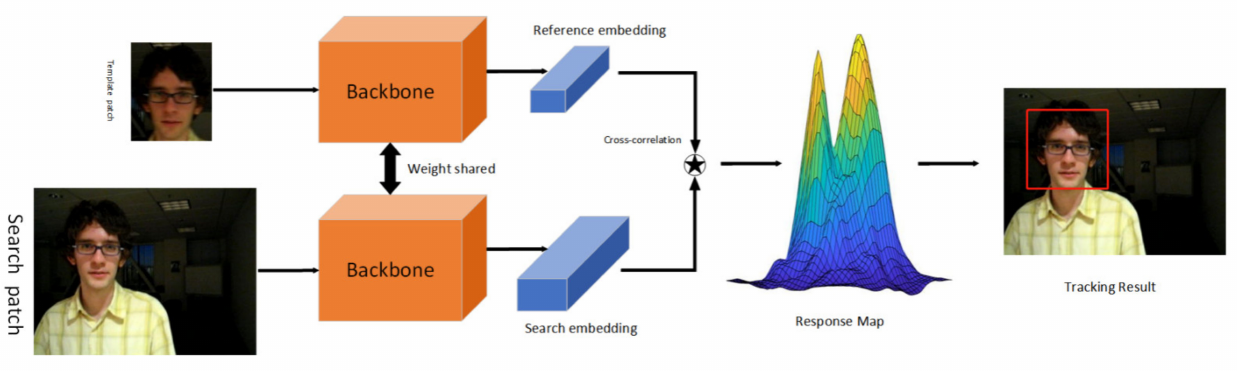
Figure 2. The Siamese tracking pipeline for generic object